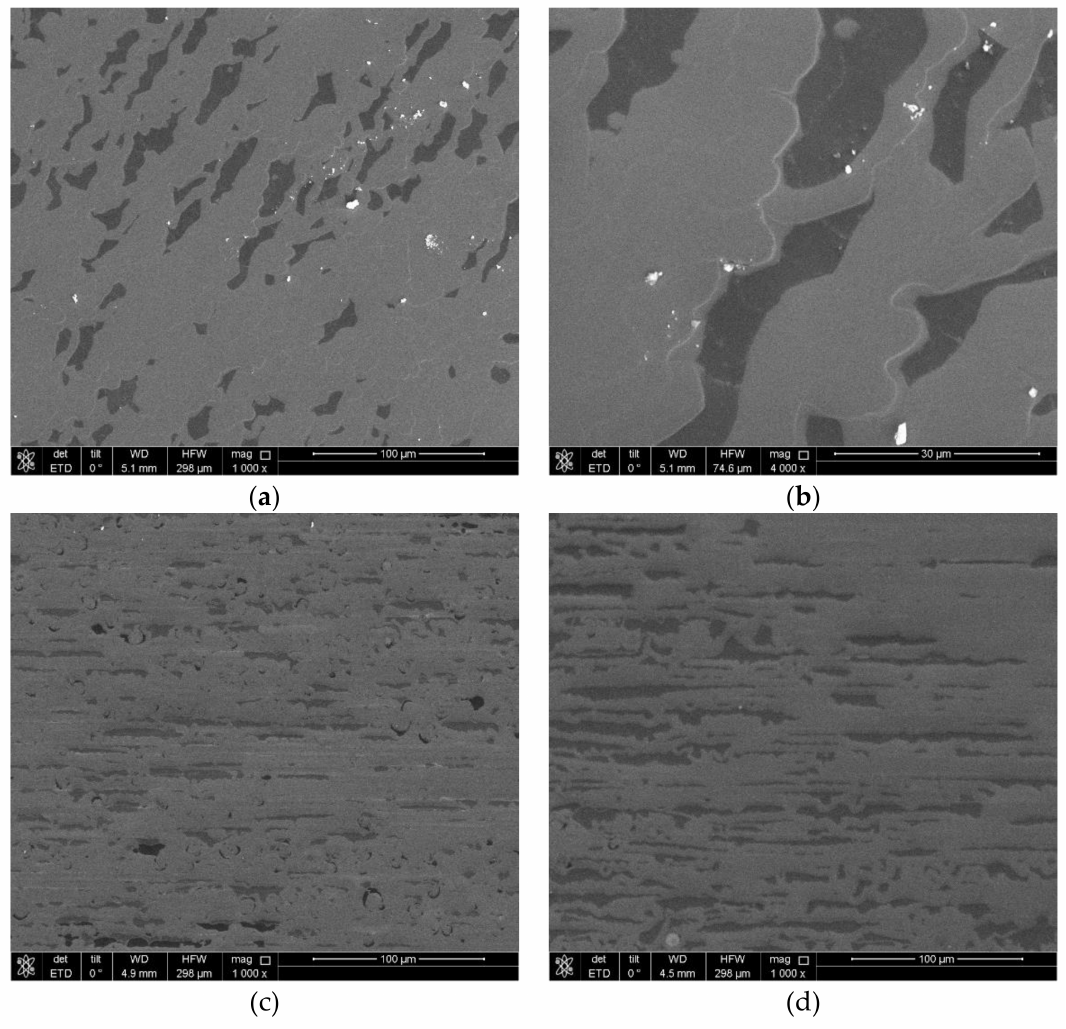
Figure 2. Scanning electron microscope (SEM) images of the surfaces of target wafers: ( a ) surface of Wafer A; ( b ) magnified view of ( a ); ( c , d ) surface of Wafer